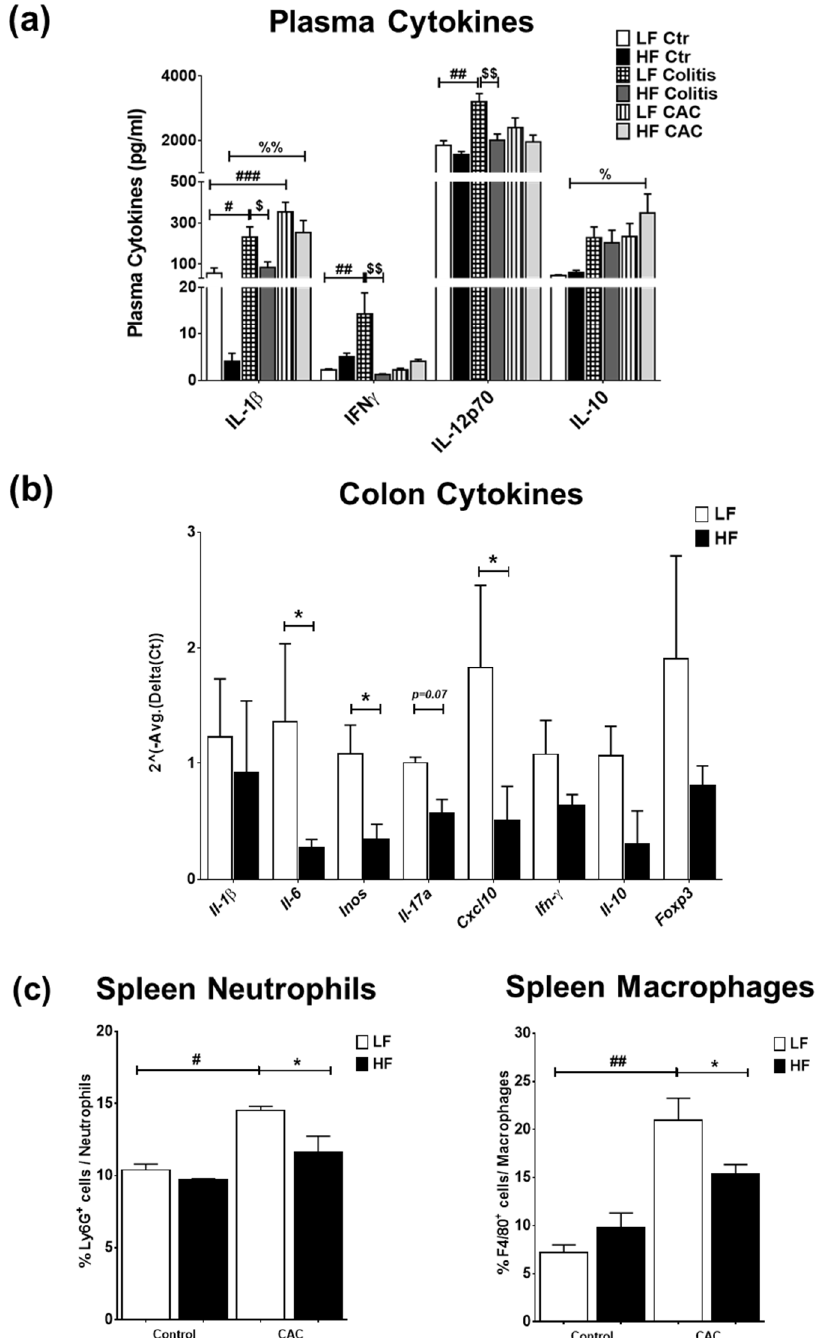
Figure 3. High-fat feeding reduces systemic and mucosal inflammatory markers. ( a ) Plasma levels of IL-1 β , IFN- γ , IL-12p70, and IL-10. Data are mean ± SEM. n = 8–12 mice per group, Significances were determined using ANOVA with post-hoc corrections. # p < 0.05, ## p < 0.01, and ### p < 0.01 LF-Colitis vs. LF-Ctr; % p < 0.05 and %% p < 0.01 HF-CAC vs. HF-Ctr; $ p < 0.05 and $$ p < 0.01 HF-Colitis vs. LF-Colitis. ( b ) Gene expression of Il-1 β , Il-6, iNOS, Il-17a , Cxcl10 , Ifn- γ , Il-10 , and Foxp3 on tumour-free colonic tissue from mice with CAC fed LF and HF diets, respectively. Expression